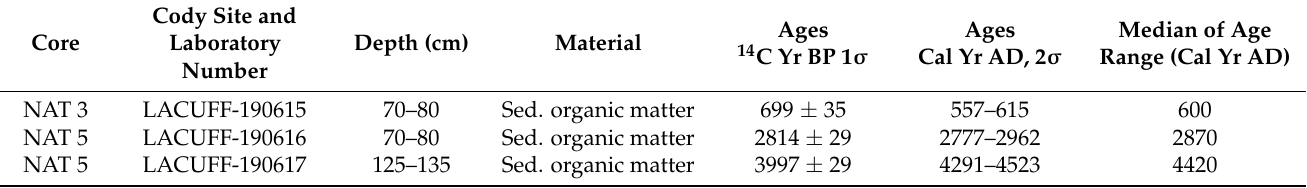
Table 1. Sediment samples selected for the 14 C dating with location, laboratory number, depth, material, and ages 14 C years conventional BP, calibrated, and median.